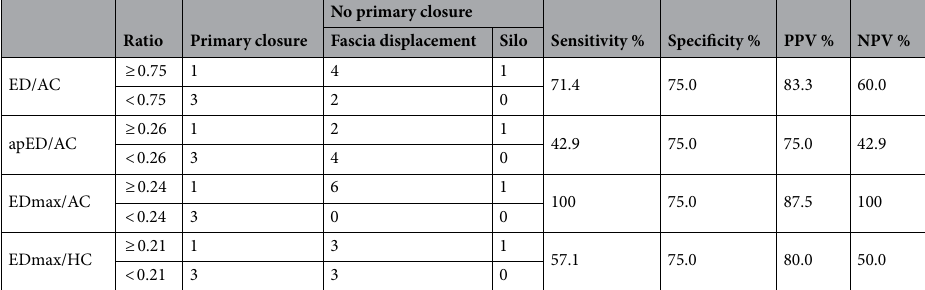
Table 3. Prediction of big exomphalos without primary closure. ED/AC: diameter of exomphalos/abdomen circumference; apED/AC: anterior to posterior diameter of exomphalos/abdomen circumference; EDmax/AC: maximal diameter of exomphalos/abdomen circumference; EDmax/HC: maximal diameter of exomphalos/ head circumference; PPV: positive predictive value; NPV: negative predictive value; ratio in